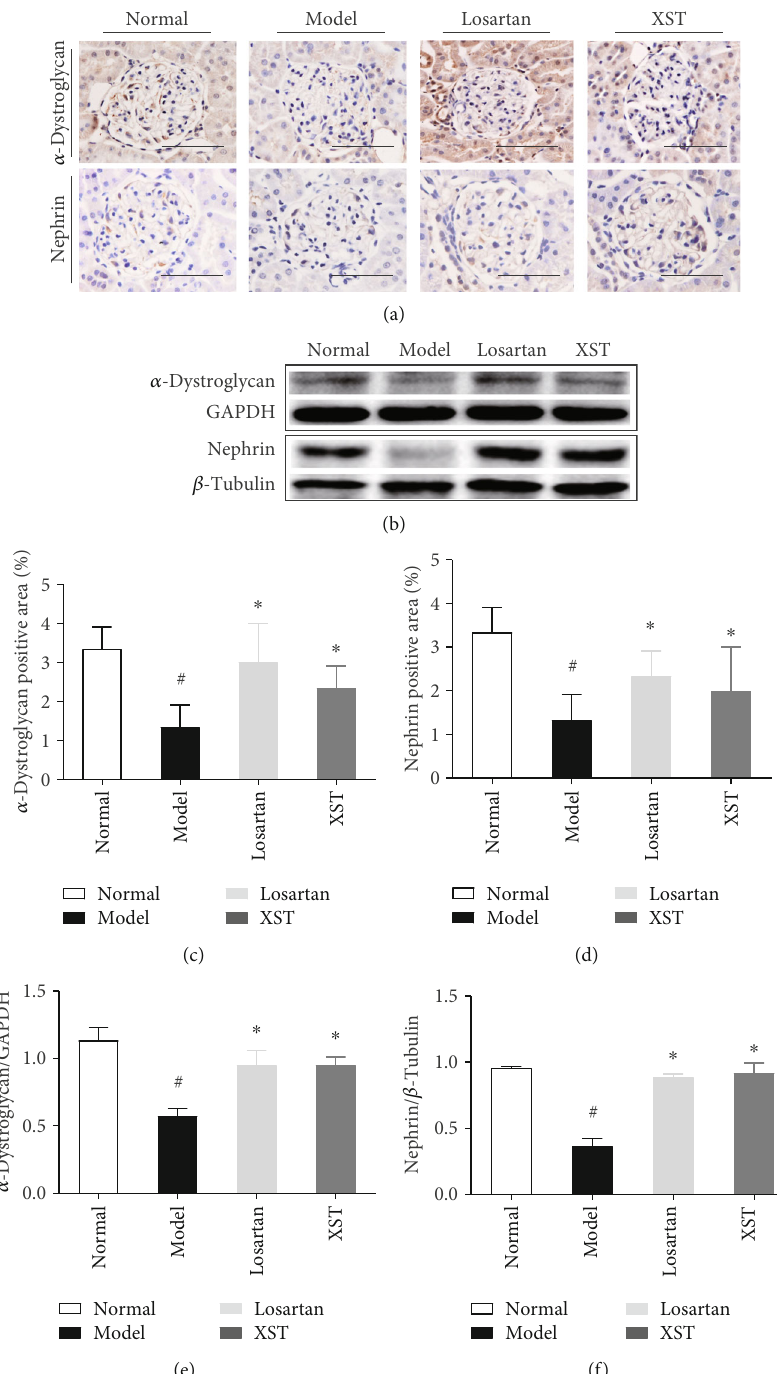
Figure 3: E ff ects of XST on expression of α -dystroglycan and nephrin in diabetic kidneys. Representative immunohistochemical staining (a) and western blotting (b) for α -dystroglycan and nephrin in the glomerulus. Quantitative analysis for α -dystroglycan and nephrin expression (c – f). Results were expressed as the means ± SEM . Scale bar = 100 μ m. # P < 0 : 05 vs. normal; ∗ P < 0 : 05 vs.